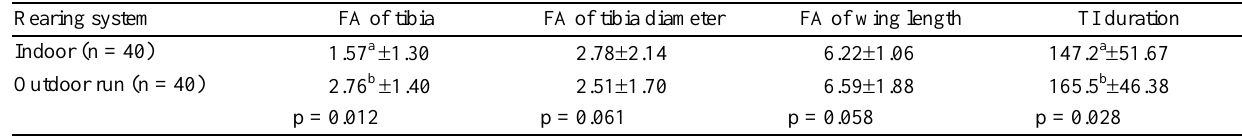
Table 5. Effects of rearing system on FA and TI duration in broilers Rearing system